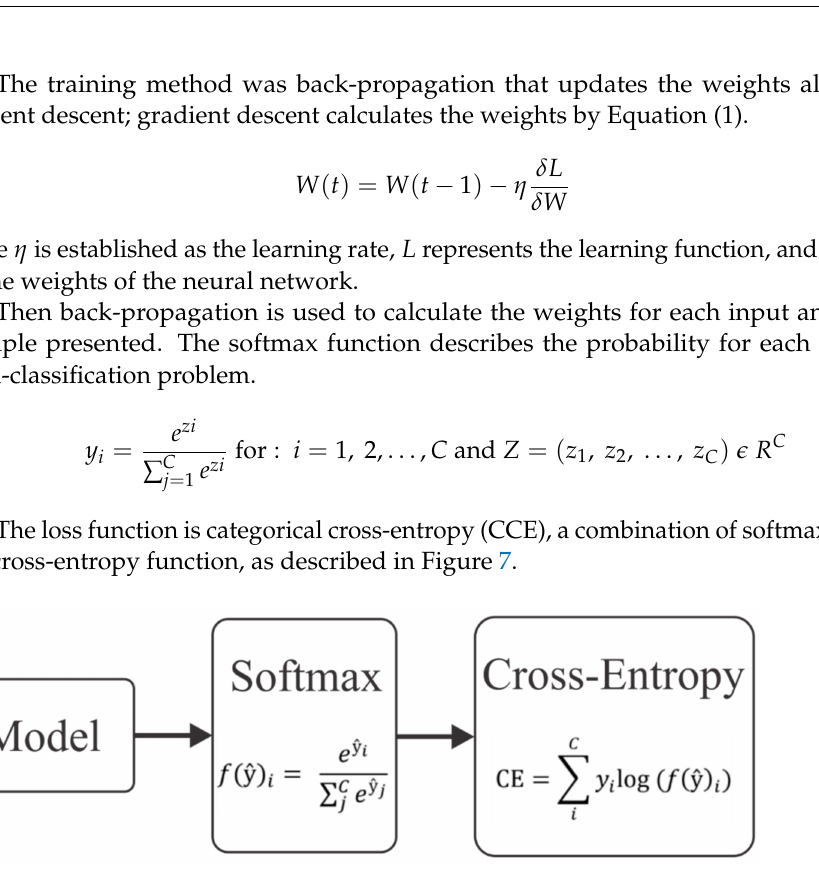
Figure 7. Softmax and cross-entropy loss function.